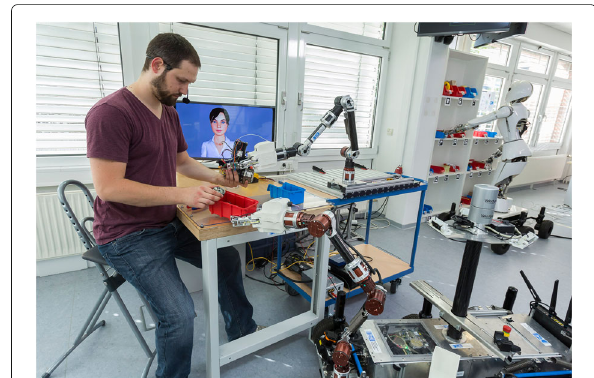
Fig. 4 Examples for humans, robots and other AI agents working in hybrid teams. Due to the possible applications and scenarios robots can be configured here as stationary or mobile systems up to even complex systems with humanoid appearance. (Copyright: Uwe Völkner/Fotoagentur